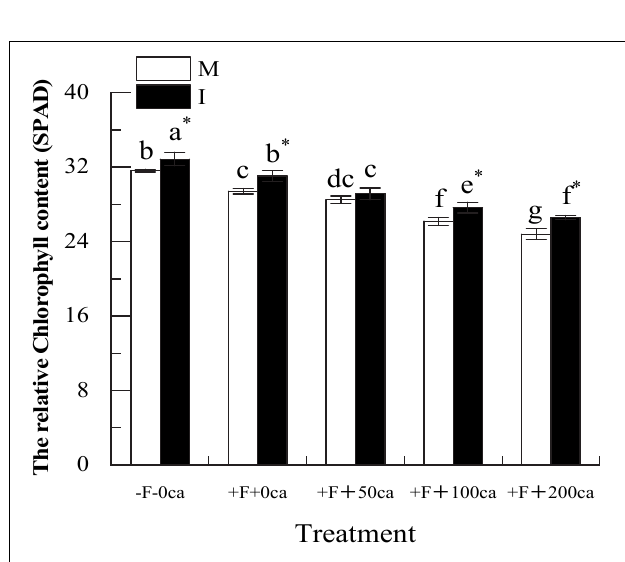
FIGURE 6 | Effects of FOF and cinnamic acid stress on tissue structure in the faba bean ( Vicia faba ) stems and the intercropping effect. Hc: Healthy cell, Xcw: Xylem cell wall, Je: Jelly cell, In: Inclusion, Dc: Deformed cell, Bc: Broken cell, Sc: Schismatic cell layer.